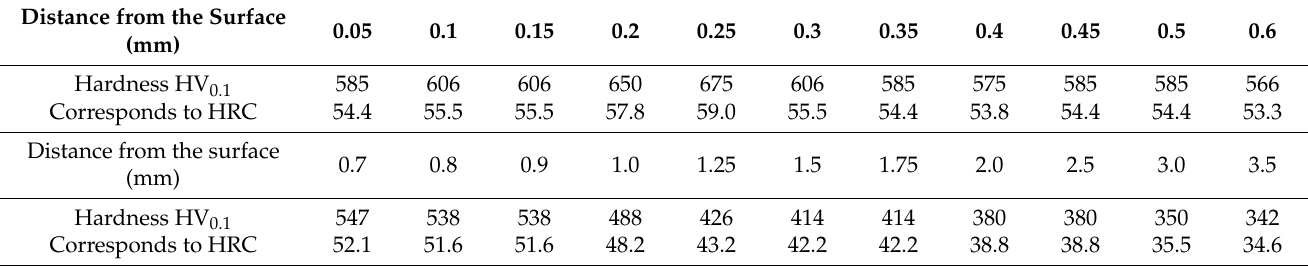
Figure 7. Microhardness measurement results for the tooth hard-faced with FM DUR 600-IG. Table 5. Microhardness of tooth hard-faced with EVB2CrMo—direction I-I.